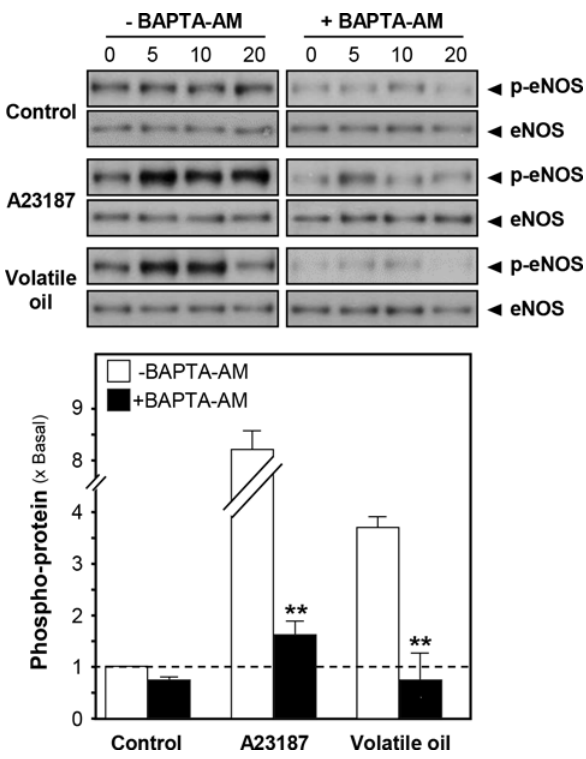
Figure 7. NRR volatile oil-induced eNOS phosphorylation is mediated by Ca 2+ /CaM pathway. Cultured HUVECs were pre-treated with serum free medium or BAPTA-AM (5 µ M) for 3 hours, and treated with NRR volatile oil (25 µ g/mL), A23187 (1 µ M, positive control) or control (serum free medium) for different time points (0 – 20 min). Phospho-eNOS Ser 1177 (~135 kDa) and total eNOS (~135 kDa) were revealed by using specific antibodies (upper panel). Quantification of phospho-eNOS protein (at 5 min) from the blot was calculated by a densitometer (lower panel). Data were expressed as x Basal where the control (untreated culture) was set as 1, Mean ± SEM, n = 4, each with triplicate samples. ** p <